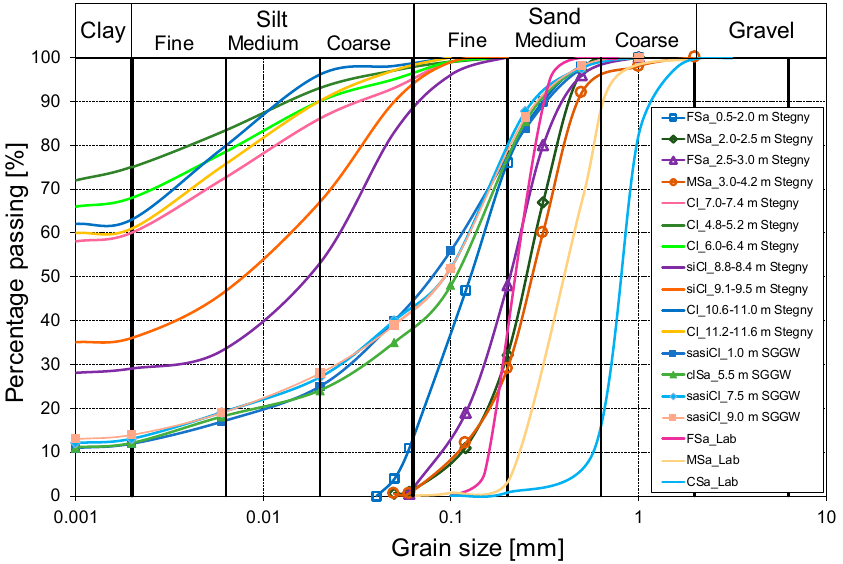
Figure 2. Grain-size distribution curves for soil samples taken directly from the test sites and assessed in the laboratory.